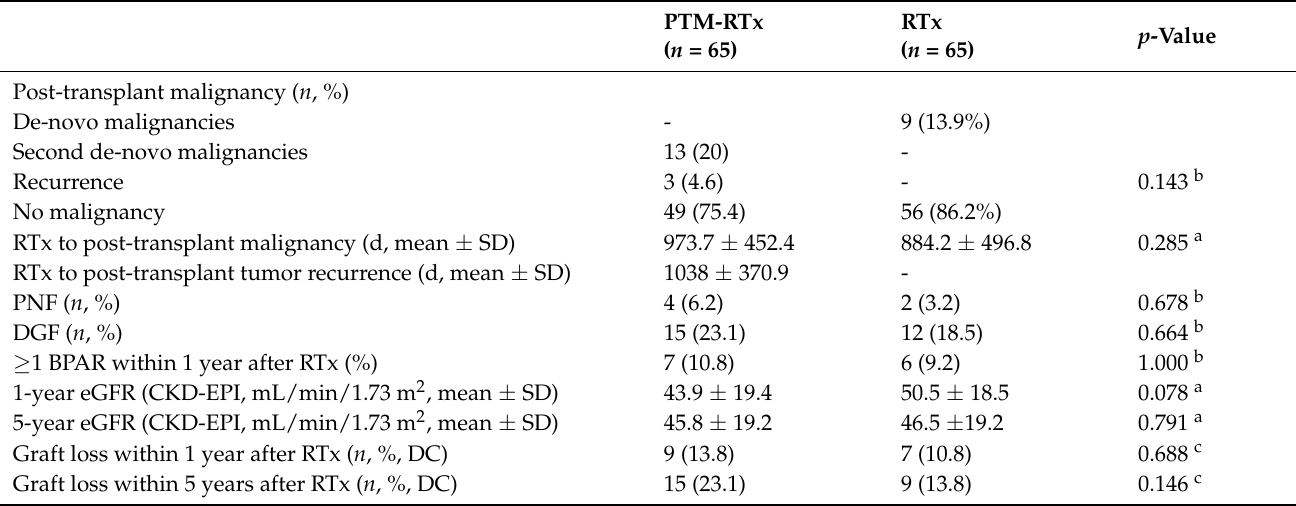
Table 2. Oncological outcome for renal transplantation recipients with and without a pretransplant malignancy, matched by age, sex and duration of immunosuppressive therapy.